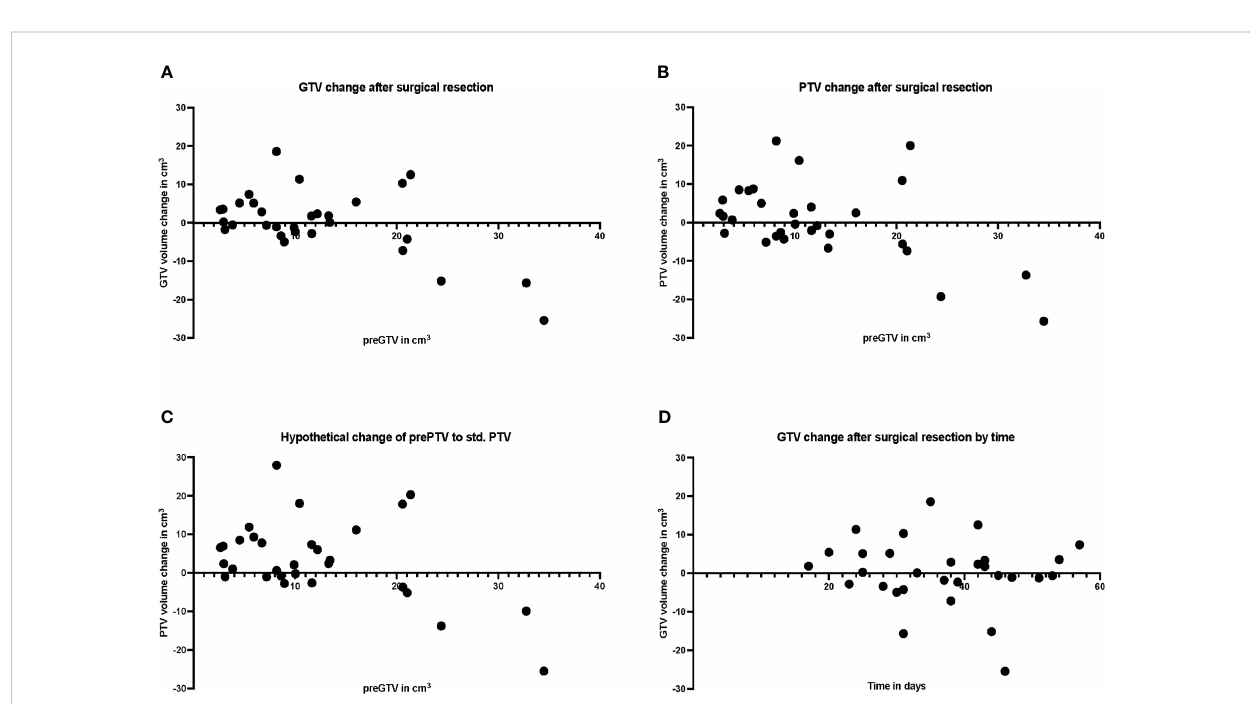
FIGURE 5 Plot of individual patient data (n = 30) for resection cavity volume changes compared with preoperative volumes, (A) for gross tumor volume (GTV), (B) for planning target volume (PTV), and (C) for standardized PTV, shown relative to preoperative (pre) GTV. (D) shows the volume change of the resection cavity after surgical resection in relation to the days between surgery and